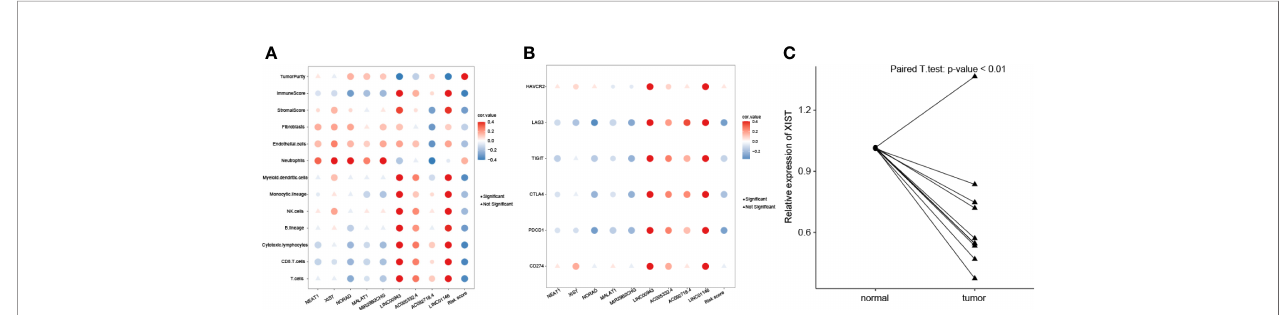
FIGURE 7 | Correlations of lncRNA expression values and immune biomarkers. (A) Signi fi cant correlations between proportions of immune cells with nine lncRNAs expression pro fi les. (B) Signi fi cant correlations between levels of immune checkpoint genes with nine lncRNAs expression pro fi les. (C) The XIST relative expression levels of normal and breast cancer samples were compared.